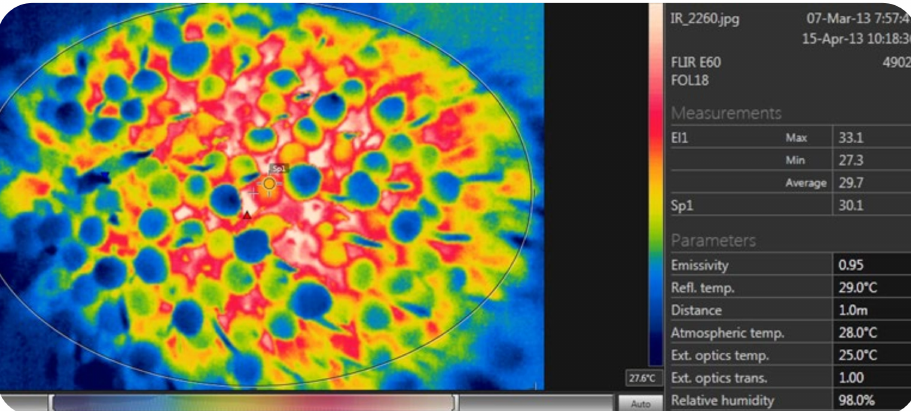
Figure 5. Determination of ROI based on prismatic